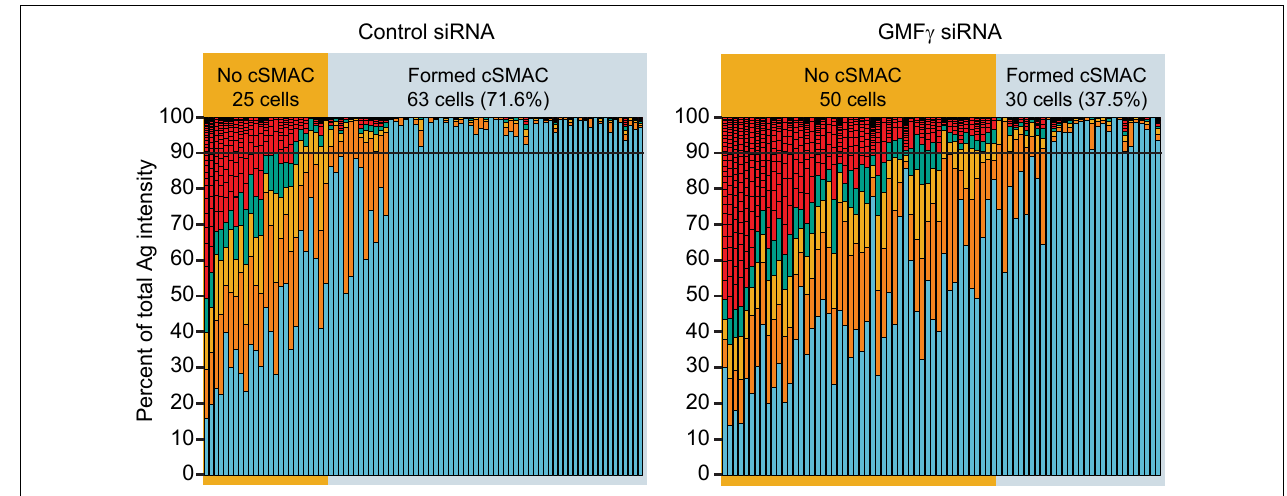
FIGURE 6 | Depleting GMF γ reduces the percent of cells that form a cSMAC. Raji D1.3 B cells that had been transfected with control siRNA or GMF γ siRNA were added to mHEL-HaloTag-expressing COS-7 APCs. The cells were fixed after 30 min and the B cell-APC interface was imaged by spinning disk microscopy. The stacked bar plots show the fraction of the total Ag fluorescence intensity in individual clusters. Each bar represents one cell and each colored segment within a bar represents a single Ag cluster. The size of the colored segment is proportional to the fraction of the cell’s total Ag fluorescence intensity that is contained within that cluster. Cells in which > 90% of the total Ag fluorescence intensity (black horizontal lines) was contained in 1–2 clusters were deemed to have formed a cSMAC. The data are from one of the 5 independent experiments that are compiled in Figure 5C